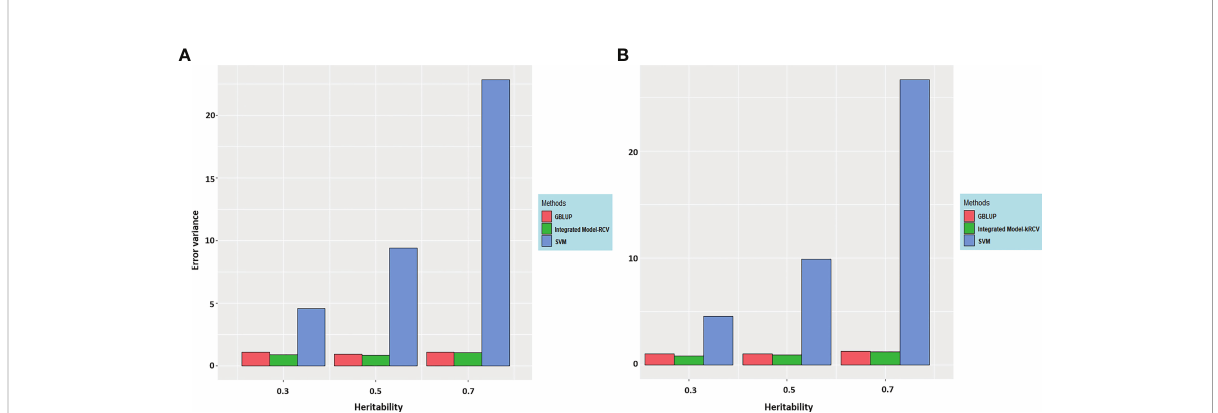
FIGURE 3 Error variance for integrated GS model at different heritability using various methods (A) RCV and (B) k-RCV in comparison to the error variance of best methods from both parametric and nonparametric i.e. GBLUP and SVR (Results from Tables 3,